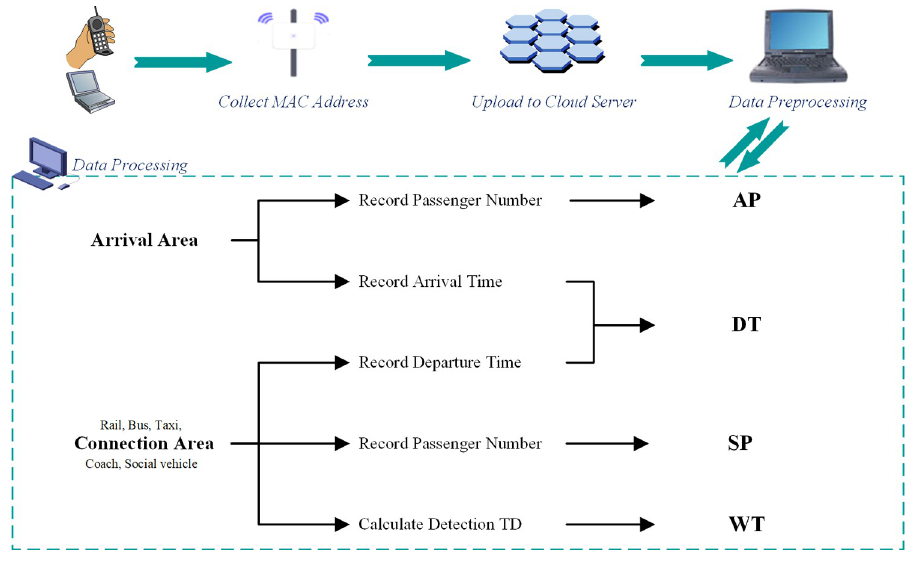
Fig 1. Wi-Fi probe data collection